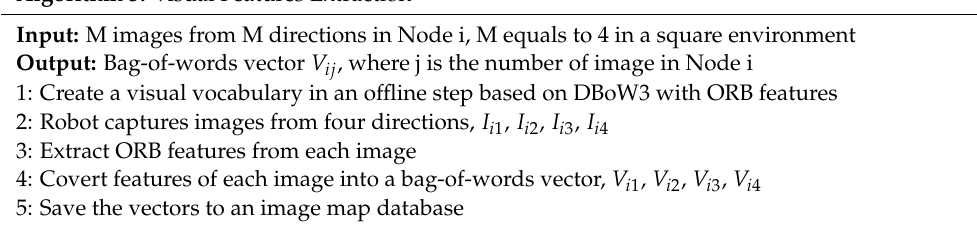
Algorithm 3. Visual Features